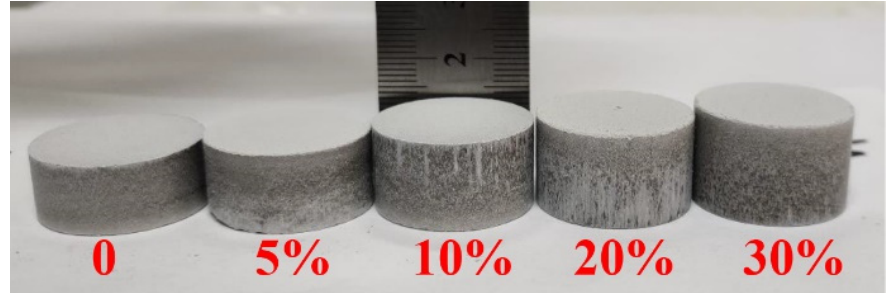
Figure 2. The pellet was formed by pressing after adding the pore-forming agent. The weight loss curve of the pellet was transformed into the reduction conversion curve of magnesium, and the reduction conversion α was solved using Equation (1).